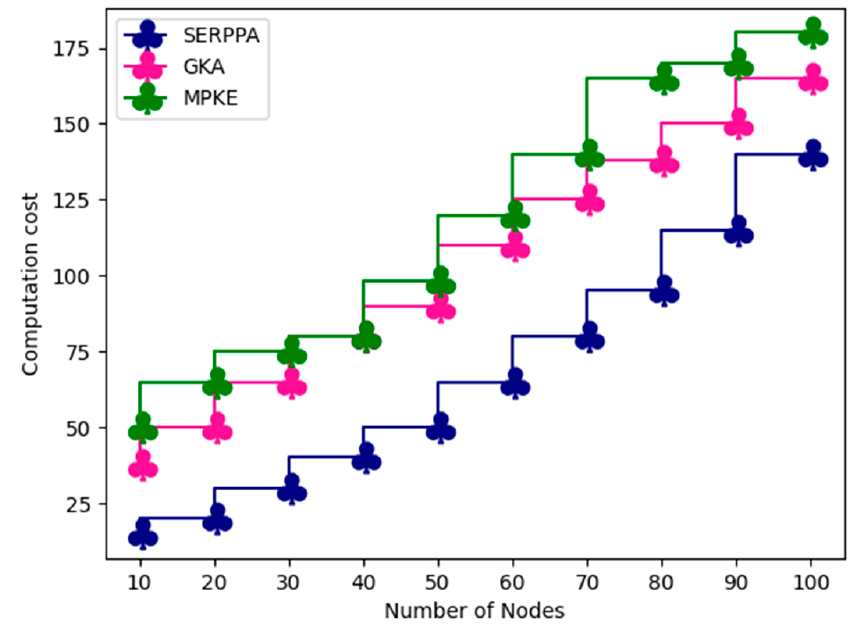
Figure 6. Computation cost vs. number of nodes.